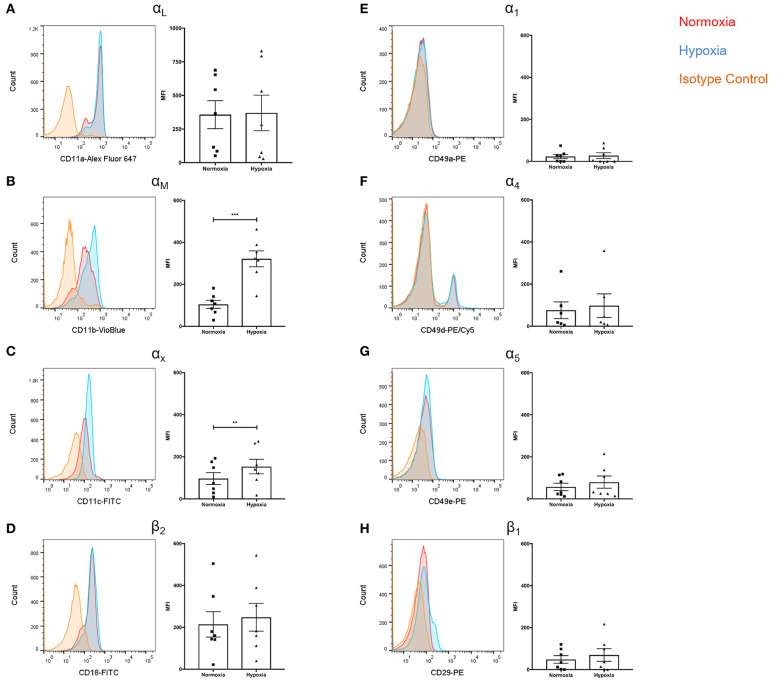
Hypoxia increased neutrophil αM and αX integrin subunit expression. Neutrophil integrin expression was examined following culture under normoxia (21% oxygen) or hypoxia (1% oxygen). Flow cytometry was used to assess expression of the integrin subunits: (A) αL, (B) αM, (C) αX, (D) β2, (E) α1, (F) α4, (G) α5, and (H) β1. Data are presented as the mean ± SEM of neutrophils isolated from seven different donors and analyzed by Wilcoxon matched pairs test. ** = p < 0.01, *** = p < 0.001. HIF, hypoxia-inducible factor.